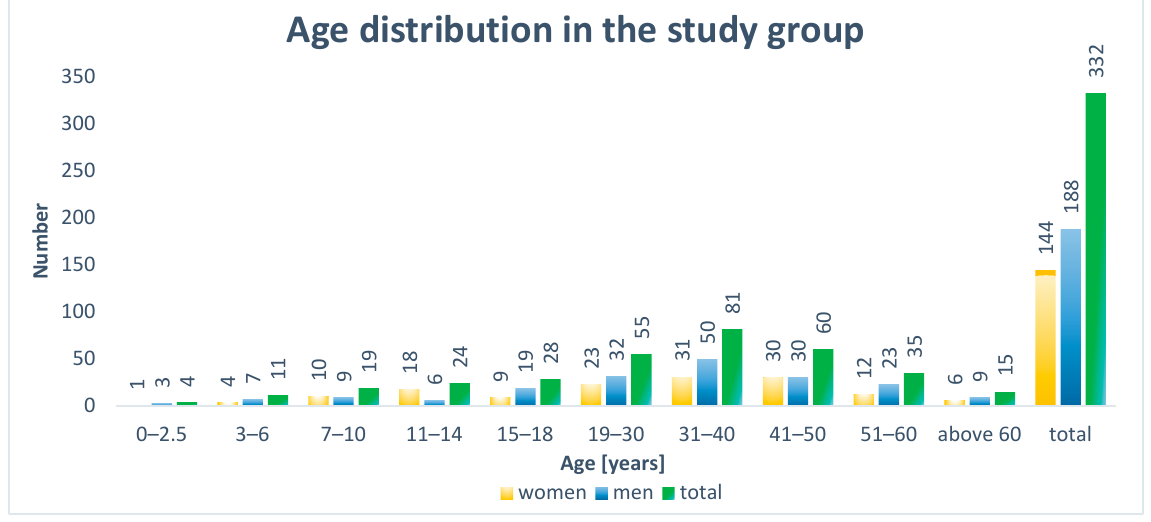
Figure 2. Age distribution in the study group.